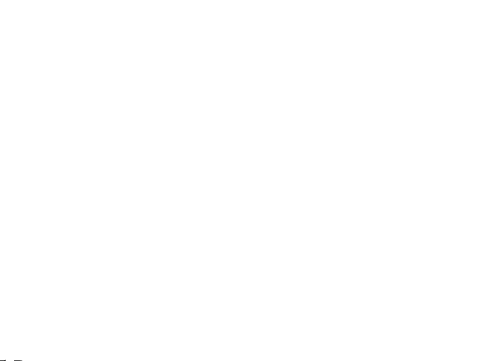
Figure 2. TGA data for CNT-COOH, CNT-Ag, and